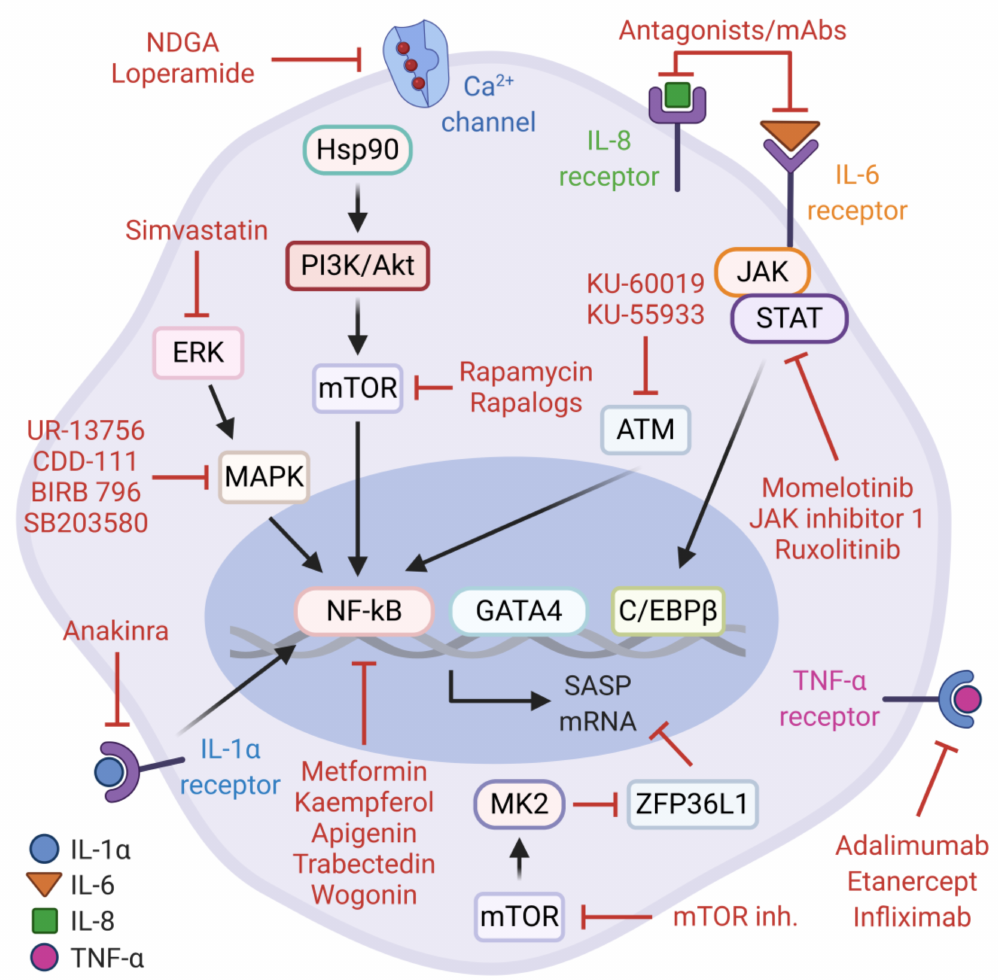
Figure 2. Anti-SASP therapies. Senostatics suppress markers of senescence and blunt SASP production. The main targets include NF- κ B and C/EBP β transcription factors and their upstream signaling networks. These types of senostatics provide the cell-intrinsic repression of the SASP. Autocrine and paracrine effects of the SASP are prevented by targeting the main components of the SASP, especially IL-1 α , IL-6, IL-8, and TNF- α